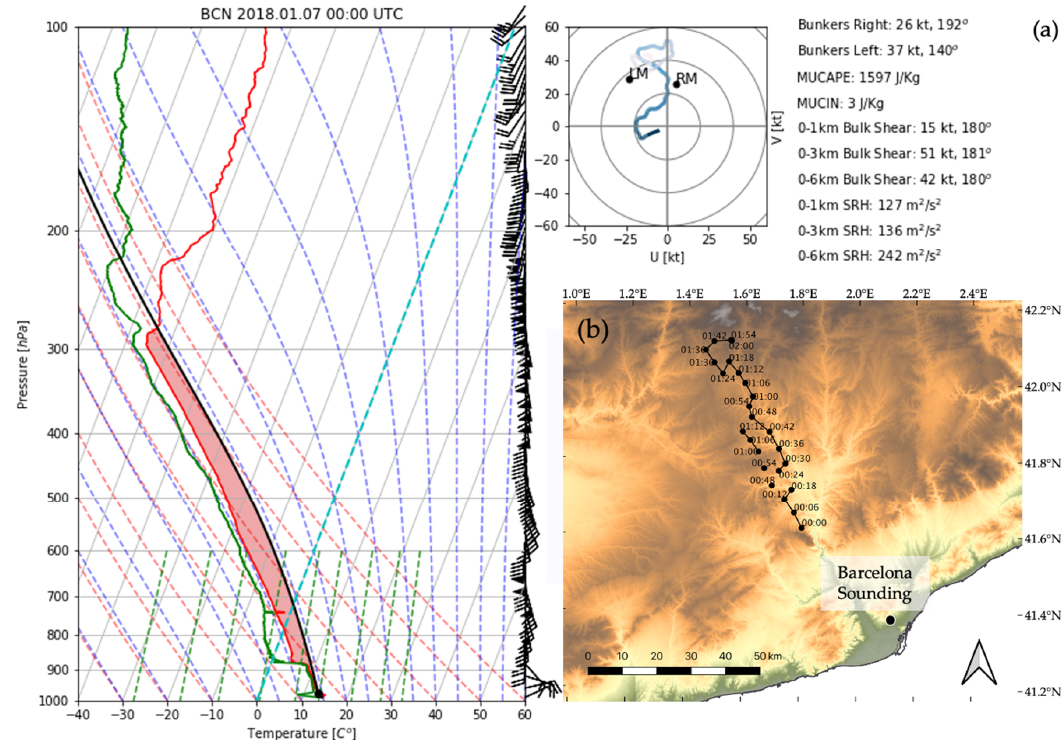
Figure 3. ( a ) Observed atmospheric profile from the Barcelona sounding on 7 January 2018 at 00 UTC. The hodograph shows wind velocity and direction up to 6 km height, in gradient blue, with dark blue starting from the surface. Potential left- (LM) and right-moving (RM) Bunkers supercell motions [62] are depicted by black dots. The black dot at the surface represents the Lifting Condensation Level (LCL). Sounding retrieved with MetPy Python’s module [63]. ( b ) Barcelona sounding location with respect to the tornado-producing storm track.